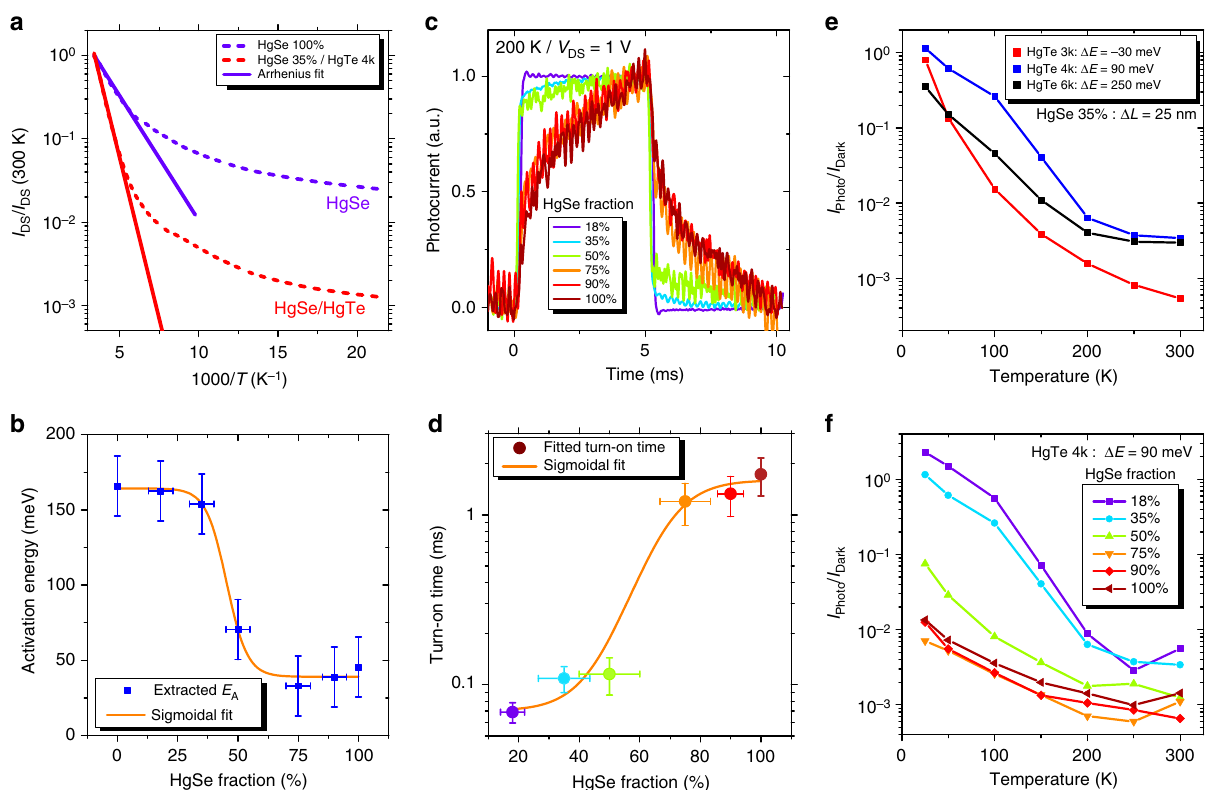
Fig. 3 Transport and photoconductive properties of colloidal quantum dot infrared photodetector. a Evolution of dark current with temperature under V = 1 V for two devices (pure HgSe and HgSe 35%/HgTe 4k). Current is normalized to its value at 300 K. The curves are fi tted to Arrhenius law at high DS temperature. b Activation energy of HgTe 4k devices with different HgSe content, extracted from an Arrhenius fi t of the cooling curves under V DS = 1 V. Horizontal error bars are determined using the error on nanocrystal size from transmission electron microscopy and determining the impact of these fl uctuations on the HgSe/HgTe ratio. Vertical error bars are set to 30 meV, which is an upper value of the fl uctuation of the measured activation energy as we repeat the measure. c Photocurrent temporal traces for HgTe 4k devices with different HgSe contents, measured at 200 K under illumination by a 4.4- µ m quantum cascade laser chopped at 100 Hz. d Turn-on times extracted from an exponential fi t of the data presented in c . Color of each data point matches its curve from c . Vertical error bars represent s.d. e Effect of Δ E : evolution of the photocurrent over dark current ratio with temperature measured on devices made of HgTe 3k, HgTe 4k, and HgTe 6k with the same amount of HgSe (same Δ L ). f Effect of Δ L : evolution of the photocurrent over dark current ratio with temperature, measured on six HgTe 4k devices ( Δ E = 90 meV) with different HgSe contents (different Δ L